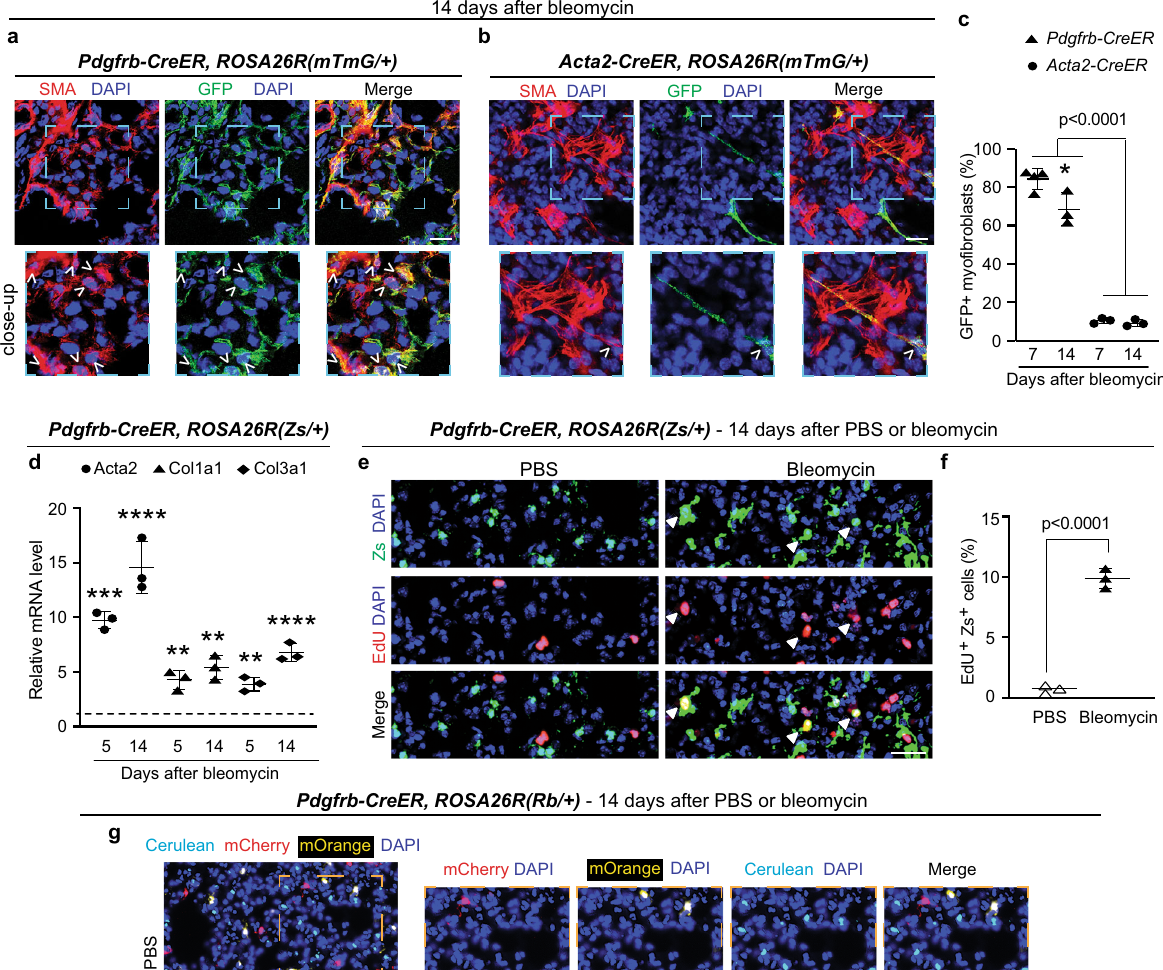
lung accumulation of excess SMA + myo fi broblasts (Fig. 3a) and collagen as demonstrated by qualitative Picrosirius red stai- ning (Fig. 3b) and the quantitative Sircol assay (Fig. 3c). Western blot analysis of whole lung lysates also revealed a reduction in collagen 1 (COL1), fi bronectin 1 (FN1) and SMA protein levels (Fig. 3d, e). These data indicate that KLF4 expression in PDGFR- β + cells is a key